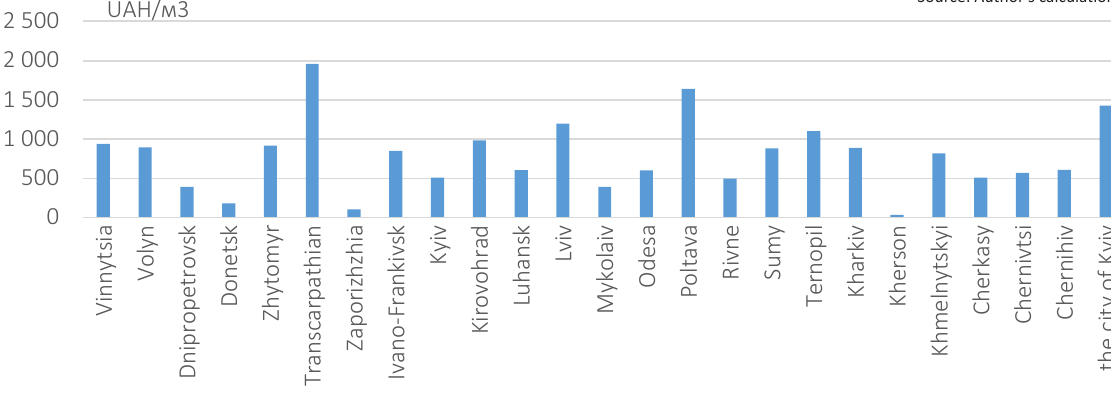
Figure 2. Water return of GRP in 2017, UAH per 1 m 3